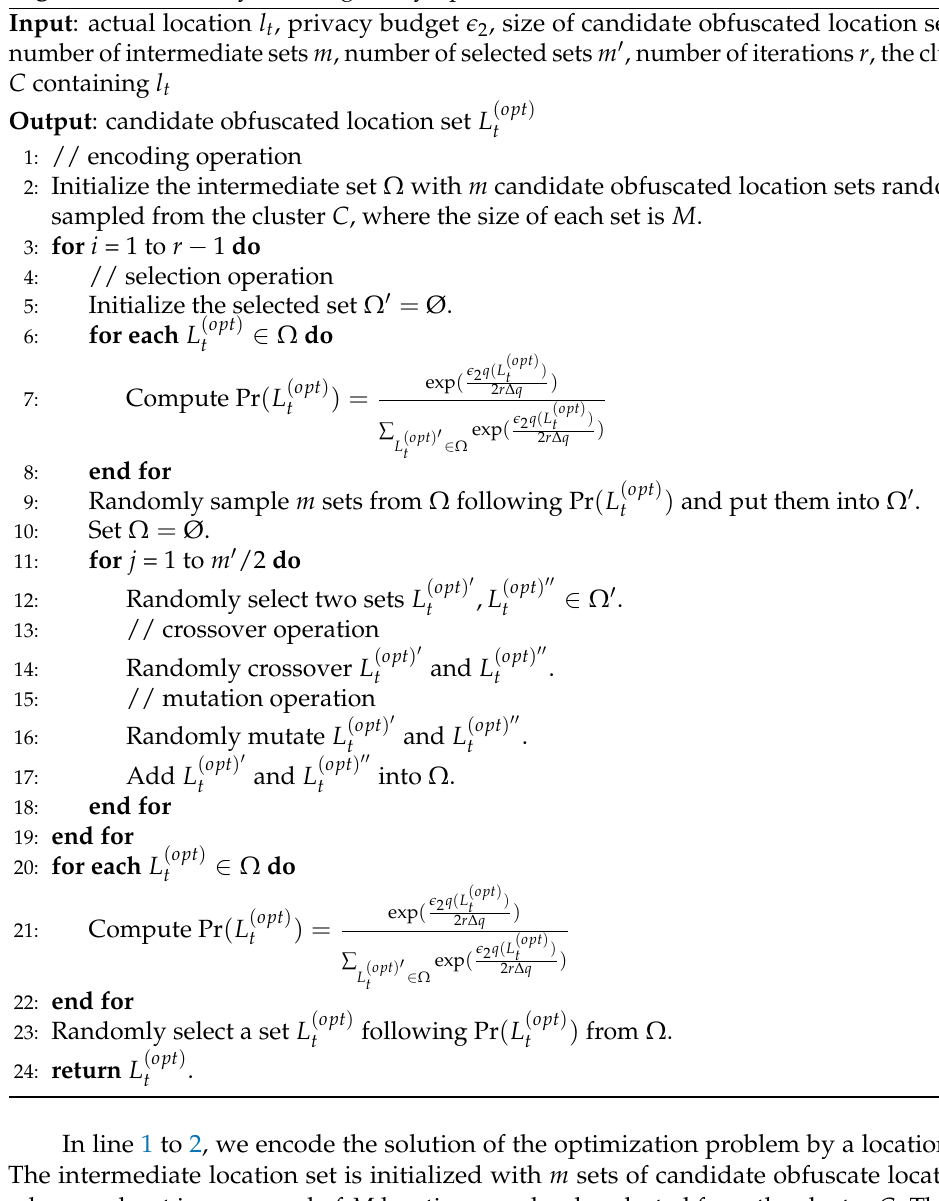
Algorithm 3 Privately selecting utility-optimized candidate obfuscated